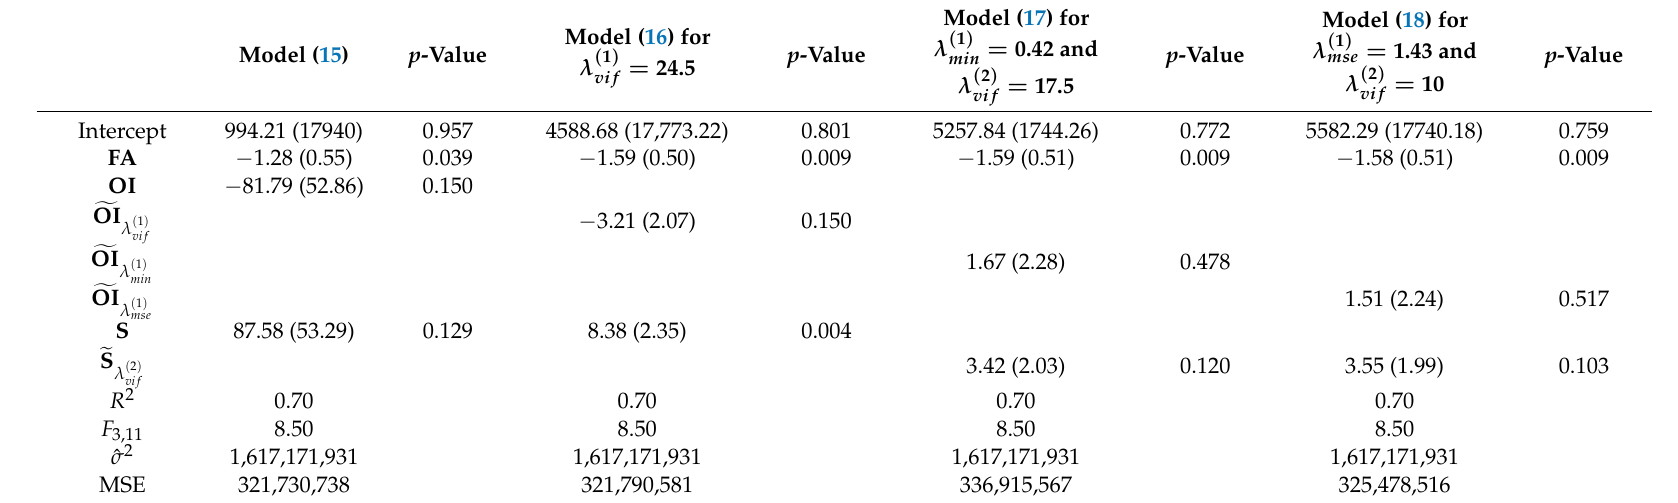
Table 1. Estimations of the models in Equations (15)–(18): Standard deviation is inside the parenthesis, R 2 is the coefficient of determination, F 3,11 is the experimental value of the joint significance contrast, and ˆ σ 2 is the variance estimate of the random